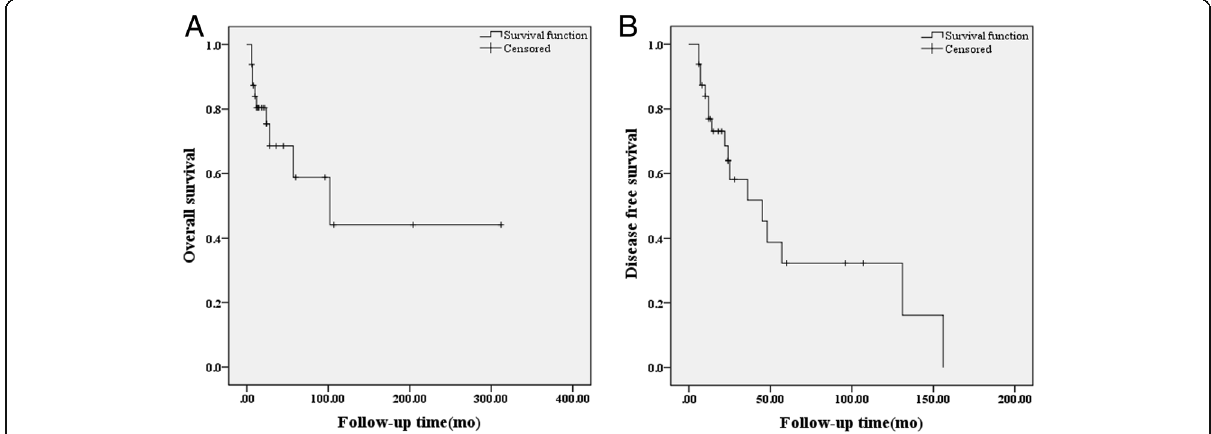
Fig. 5 Survival curves of mediastinal FDCS, overall survival ( a ) and disease-free survival ( b